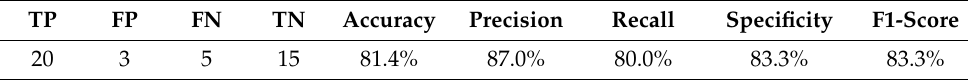
Table 3. Evaluation criteria for the classification ability.